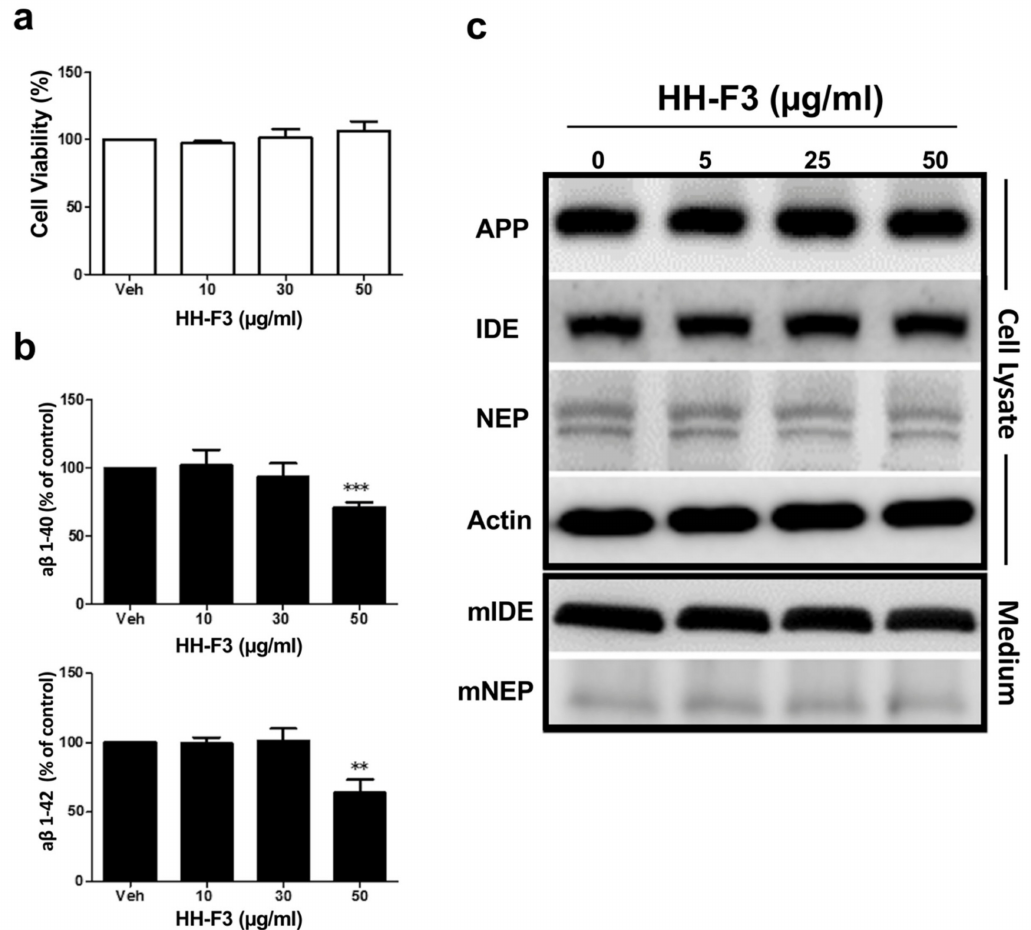
Figure 1. GP extract HH-F3 reduced A β 40 and A β 42 secretion from SH-SY5Y-APP 695 cells. SH-SY5Y-APP 695 cells were treated with varying HH-F3 concentrations at 0, 10, 30, and 50 µ g/mL for 24 h. ( a ) Effects of HH-F3 on cell viability. ( b ) Levels of A β 1–40 and A β 1–42 were assayed by ELISA in media of SH-SY5Y-APP 695 cells treated with HH-F3. ( c ) NEP and IDE were measured by Western blot in the cell lysates and conditioned medium of SH-SY5Y-APP 695 cells treated with indicated concentrations of HH-F3. Data were analyzed by Student’s t -test. Levels of significance are shown as ** p < 0.01 and *** p <